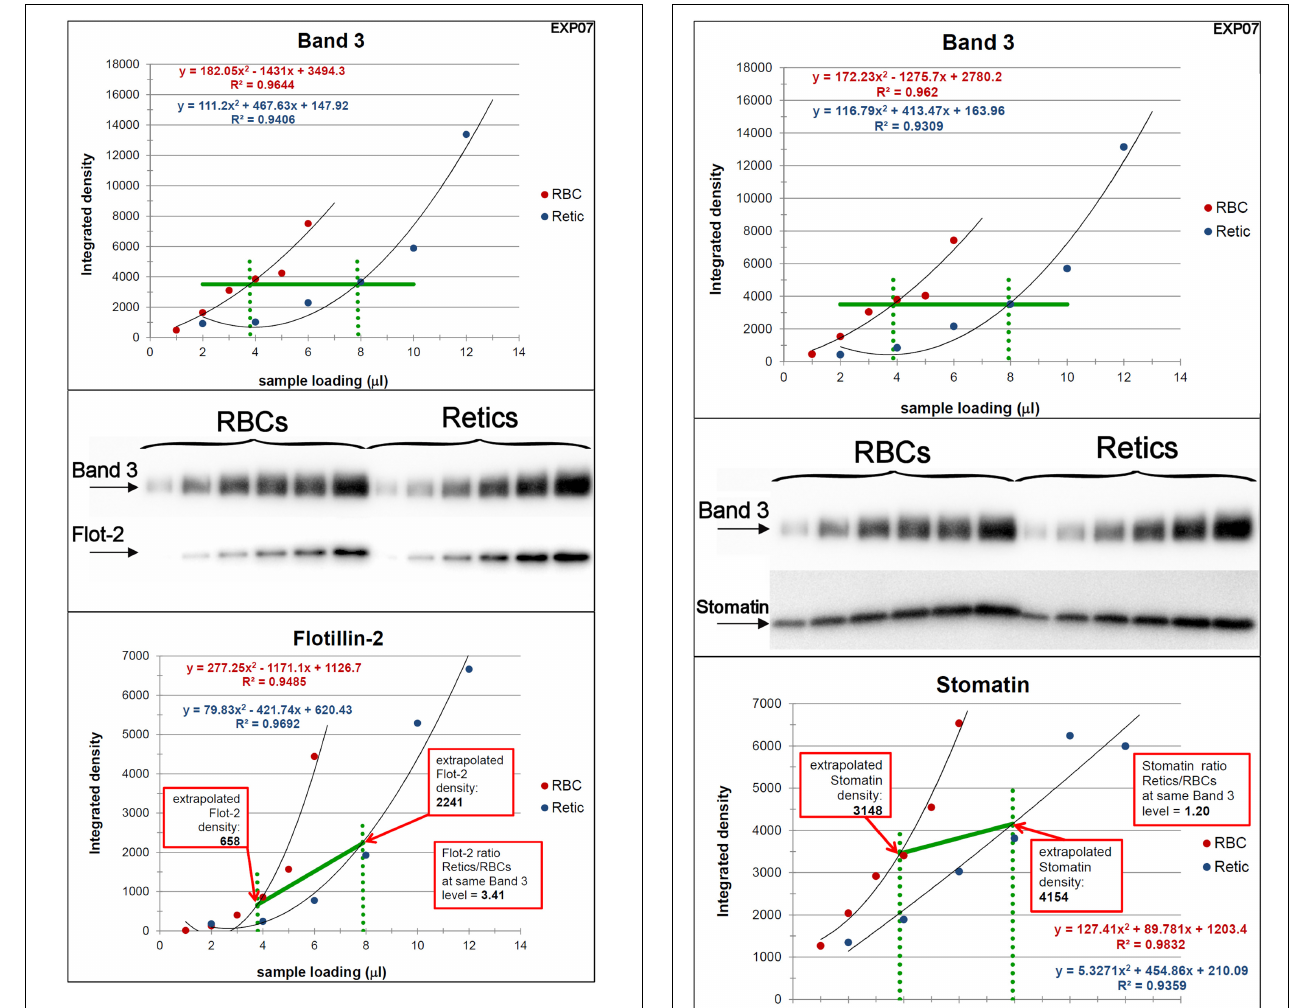
FIGURE 3 | Quantification of the relative amounts of flotillin-2 with respect to Band 3 in Retics and RBCs. The integrated densities of Band 3 obtained by densitometry of the Western blotting membrane shown in the figure (the two series of RBC and Retic samples were loaded in the same gel) were fitted with a polynomial curve (2nd order), one for the RBC and one for the Retic series (Band 3 graph). The two curves were intersected with a horizontal line at a Y value taken approximately mid-way on the polynomial curves (horizontal green line in the Band 3 graph). From the intercepts between the polynomials and the horizontal green line, vertical lines (dotted green lines) were projected on the X axis. The intercepts on the X axis were taken as the loading values (in µ l) that would give the same intensity (amount) of Band 3 for RBCs and Retics. These values were used to extrapolate, from the graph where flotillin-2 integrated densities were similarly interpolated by a parabolic function (flotillin-2 graph), the flotillin-2 densities expected for an equal amount of Band 3 in RBCs and Retics. The ratio between the flotillin-2 density extrapolated on the Retic curve and that extrapolated on the RBC curve gave the ratio of flotillin-2 between Retics and RBCs at the same level of Band 3. This procedure was repeated in 11 independent experiments (see detailed data in Supplementary Material ).